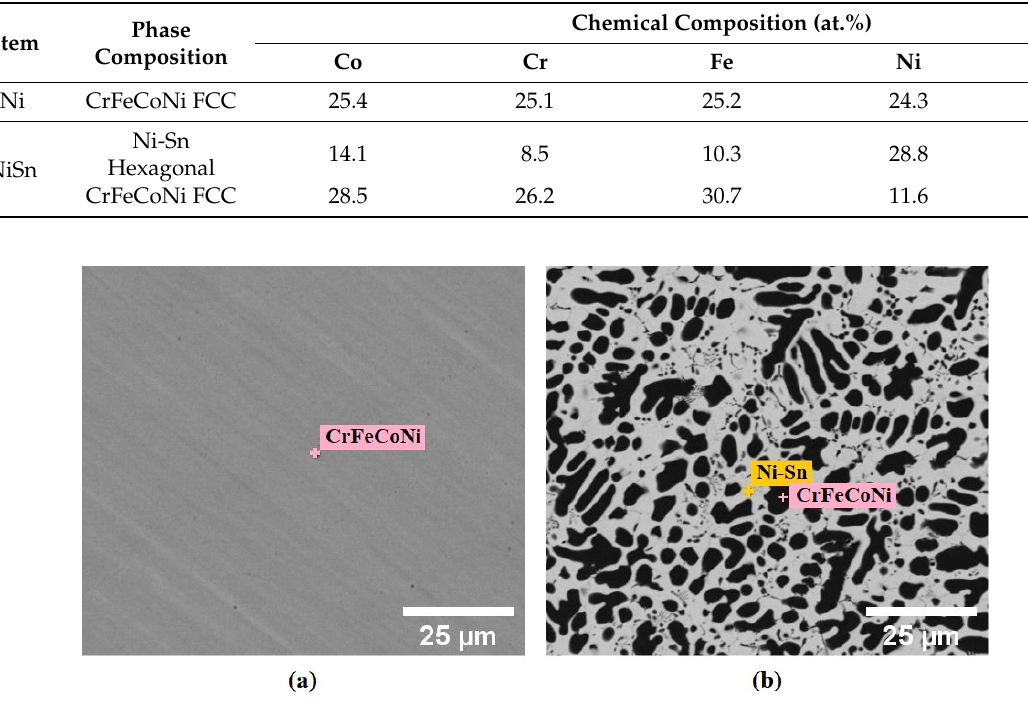
Figure 2. BSE-SEM micrographs showing EDS spots of as-cast HEA samples; ( a ) CrFeCoNi and ( b ) CrFeCoNiSn.